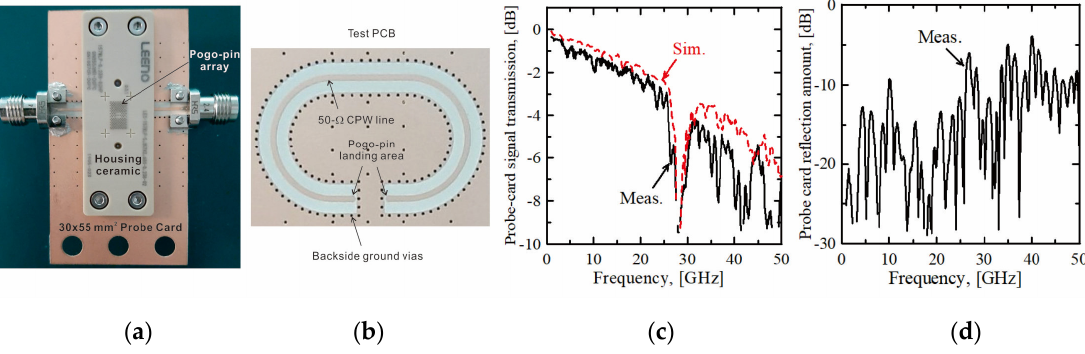
Figure 5. Photographs of ( a ) the probe card and ( b ) the test PCB, and ( c ) the total insertion and ( d ) reflection losses.